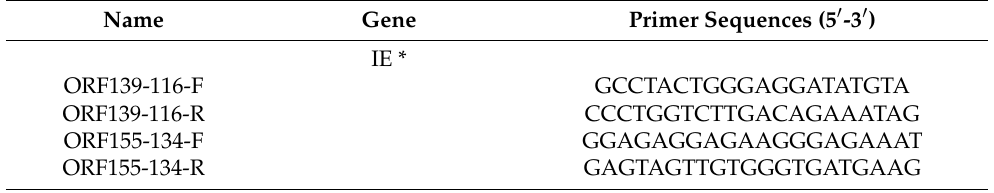
Table 1. Primer pairs used to detect mRNA of KHV genes post-infection.